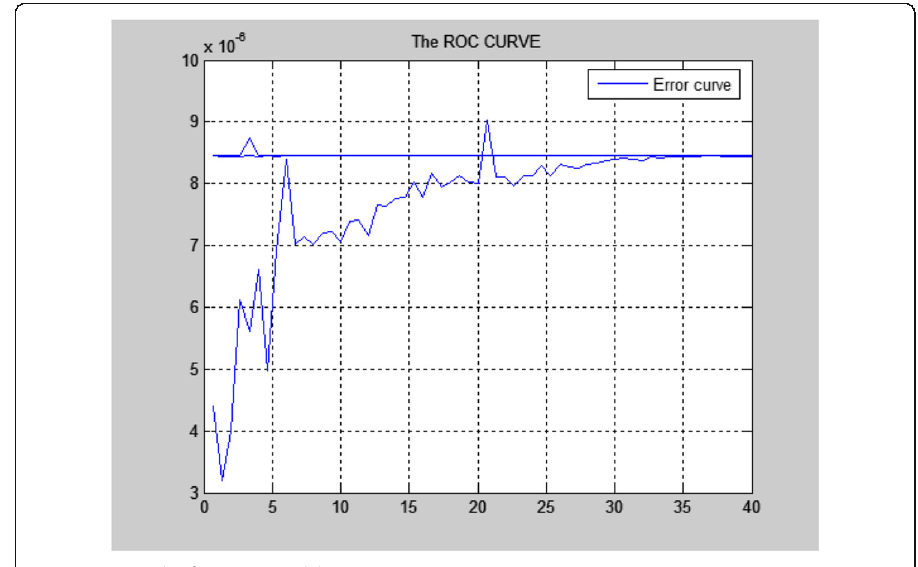
Fig. 5 ROC graph of DWSVM